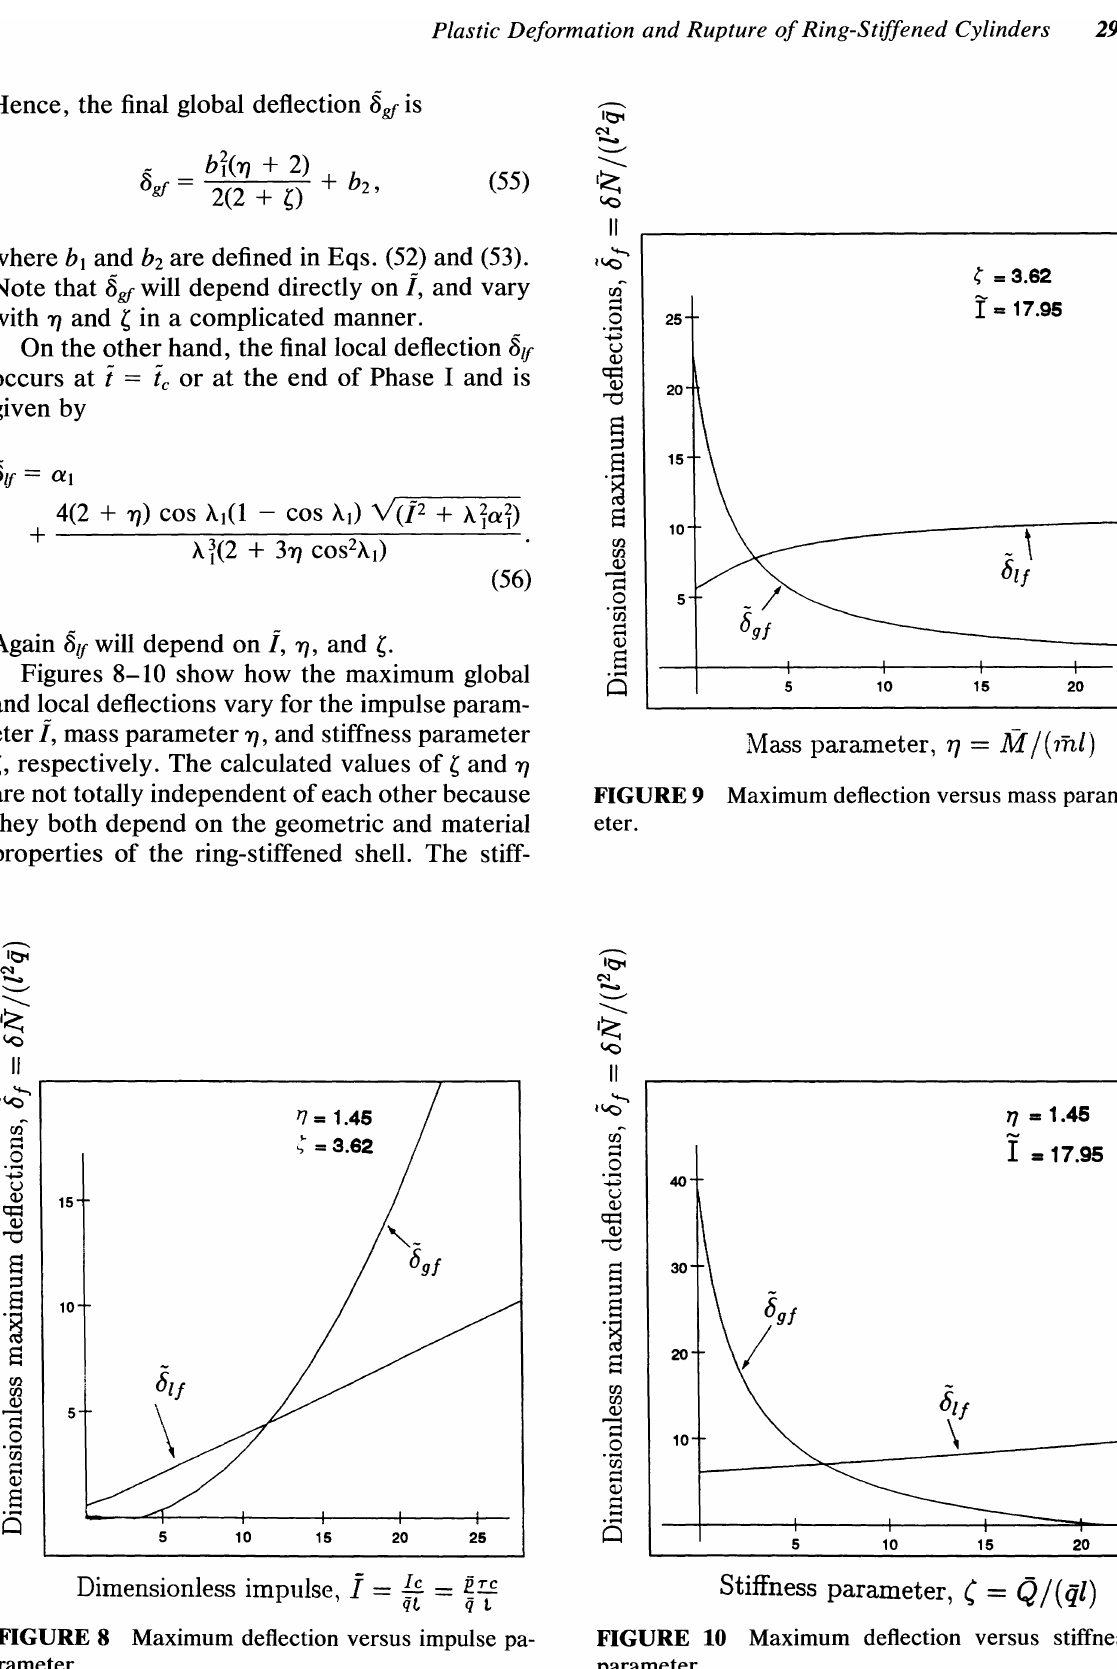
FIGURE 8 Maximum deflection versus impulse pa rameter.